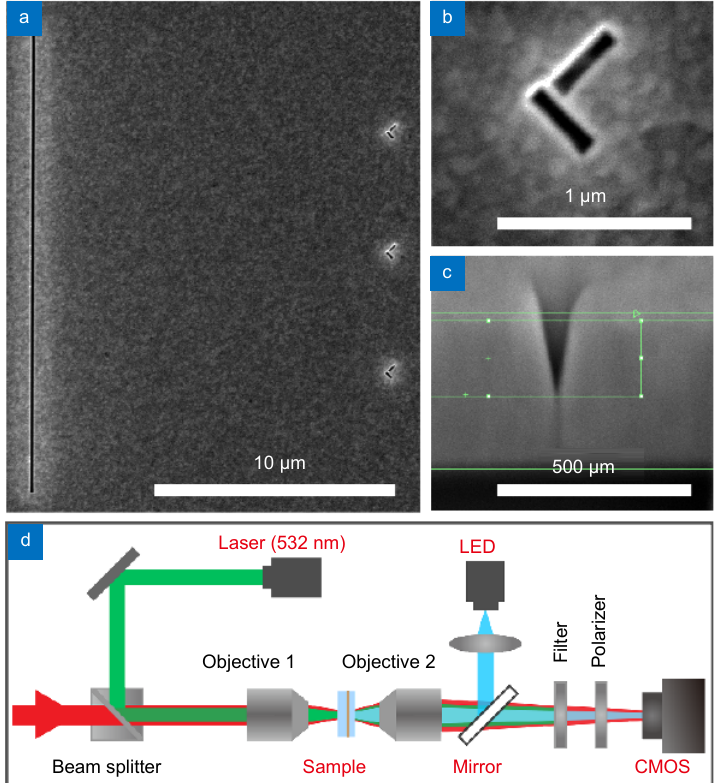
Fig. 4 | ( a ) SEM image of the fabricated structure. ( b ) Zoomed-in SEM image of a plasmonic emitter. ( c ) Cross-section of a nanogroove antenna. The green lines is used to measure the thickness of the gold film and the depth of the nanogroove antenna. ( d ) Schematic of the measurement